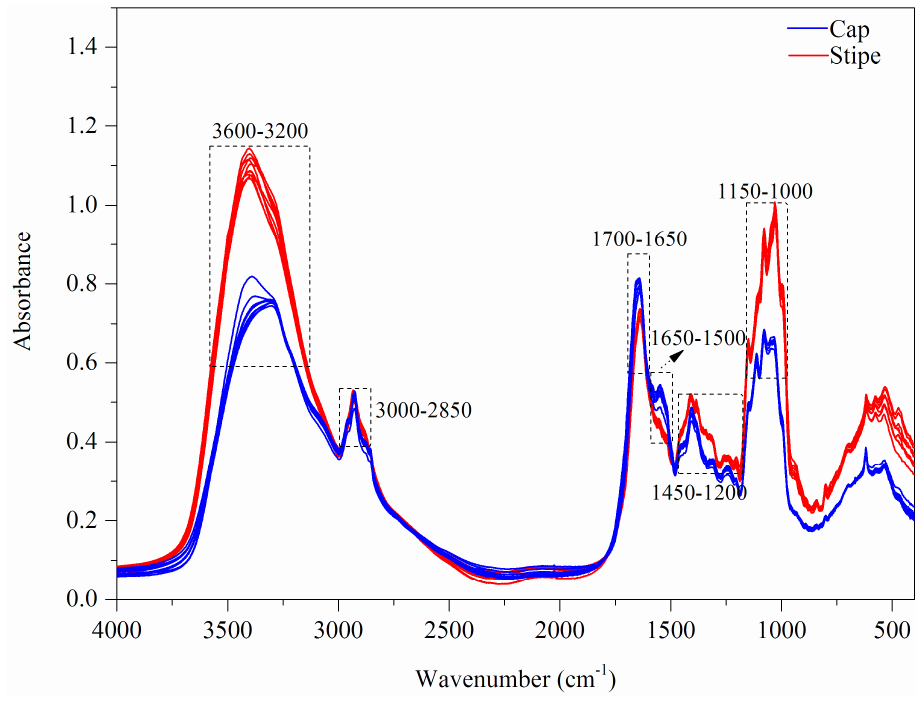
Figure 4. FT-MIR fingerprints of mushroom samples.